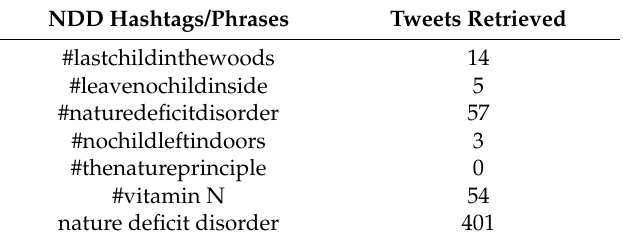
Table 1. Hashtags and phrases. NDD